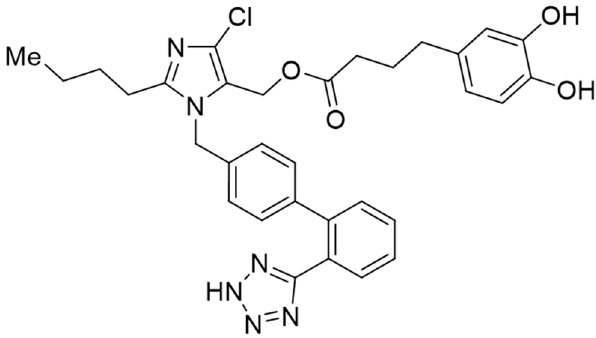
Figure 2. Structure of GGN1231 compound.